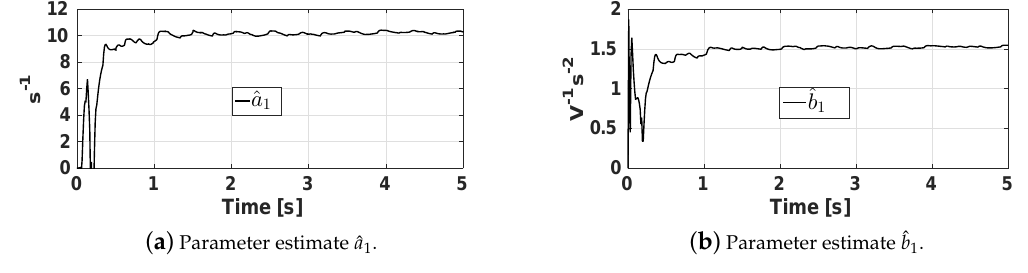
Figure 6. Parameters ˆ a 1 and ˆ b 1 estimated by the RLSM. Table 2. Parameter estimates ˆ a i and ˆ b i of the